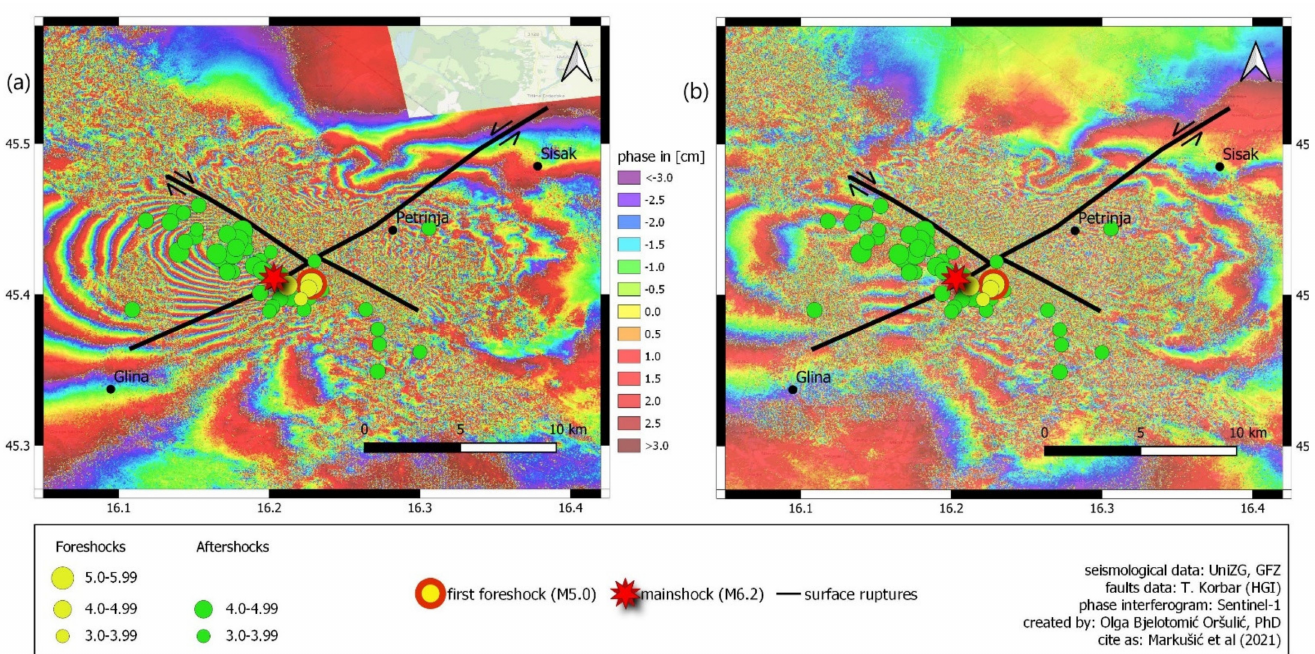
Figure 7. Interferogram of the ( a ) Sentinel-1A ascending orbit T146 and ( b ) Sentinel 1-B descending orbit T124. Each colour fringe corresponds to 2.8 cm of ground displacement (corresponding to a displacement of half of a wavelength of 5.6 cm, since the origin of the data is C-band radar).